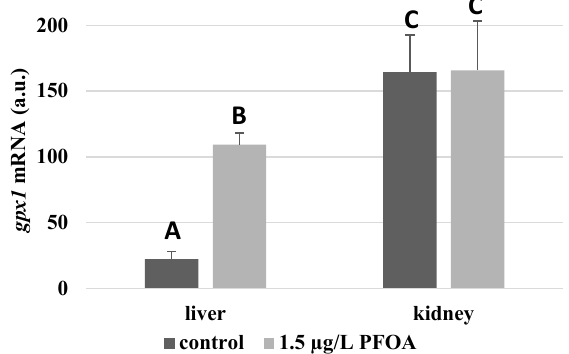
Figure 3. gpx1 mRNA expression levels in the liver and kidney of T. newnesi exposed to PFOA and unexposed (the control group). Values (arbitrary units) are indicated as mean ± SD. Transcription levels were normalized to the gapdh housekeeping gene. Different letters correspond to significant statistical differences ( p < 0.05) among different means (Student–Newman–Keuls test), with ten specimens per experimental group.